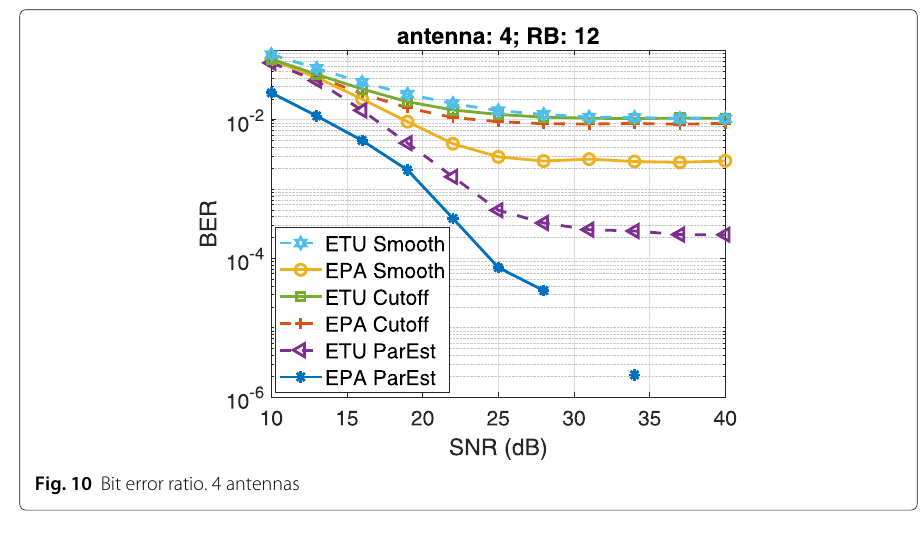
Fig. 10 Bit error ratio. 4 antennas